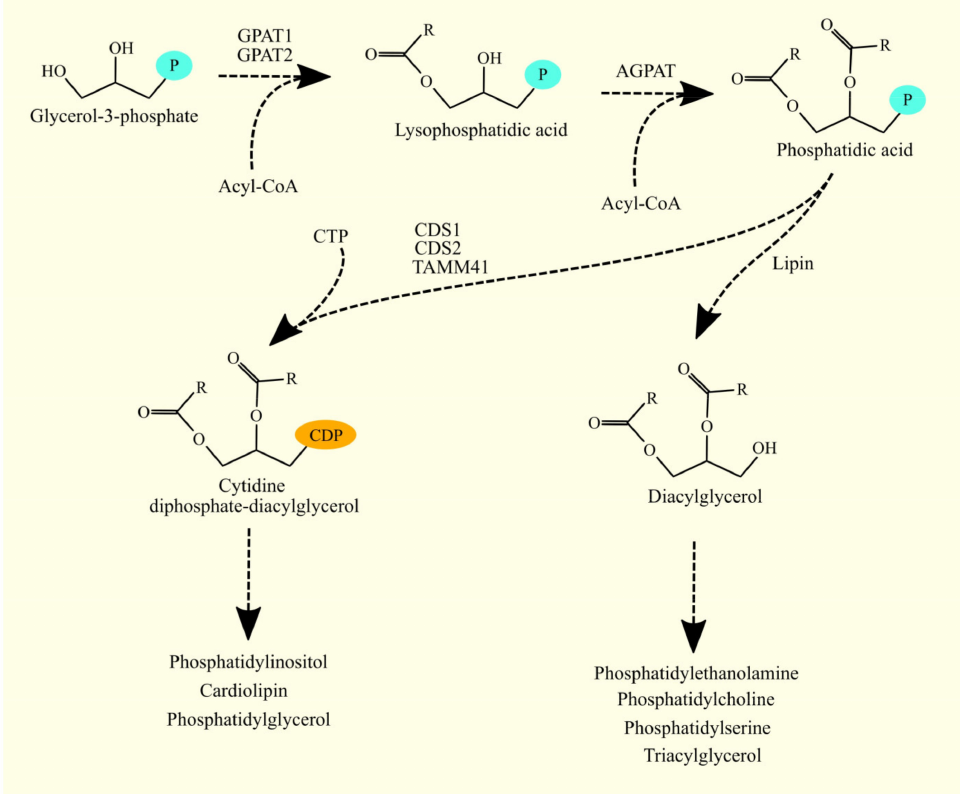
Figure 4. Glycerophospholipid and TAG synthesis. The synthesis of these compounds begins with glycerol-3-phosphate. The acyl group is transferred to the sn -1 position of this compound by GPAT, resulting in lysophosphatidic acid (1-acylglycerol-3-phosphate). In the next reaction, the second acyl group from an acyl-CoA is transferred to the sn -2 position by AGPAT, producing phosphatidic acid. Phosphatidic acid can undergo two different reactions. Its phosphate group can be removed by lipin to generate DAG, which can then produce PE, PC, PS, and TAG. Alternatively, phosphatidic acid can be converted to CDP-DAG by CDS1, CDS2, or in the mitochondria by TAMM41. CDP-DAG can then be converted to PI or, in the mitochondria, to PG or